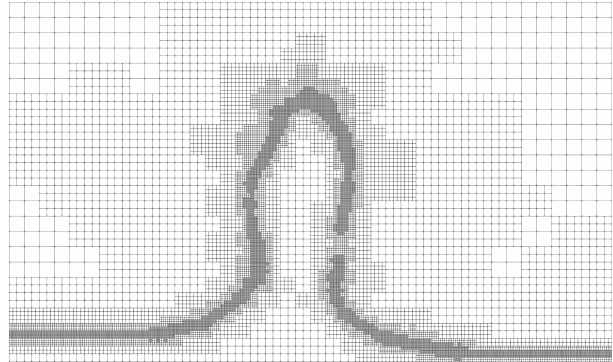
Figure 9. Adaptively refined grid for the first time step of the simu- lation. We can see that the grid is refined to a high level at the inter- face between the salt and the sediment overburden, where the high- est velocity gradients appear. On the contrary, it is coarsened where the velocity has small gradients, particularly in the upper right and upper left